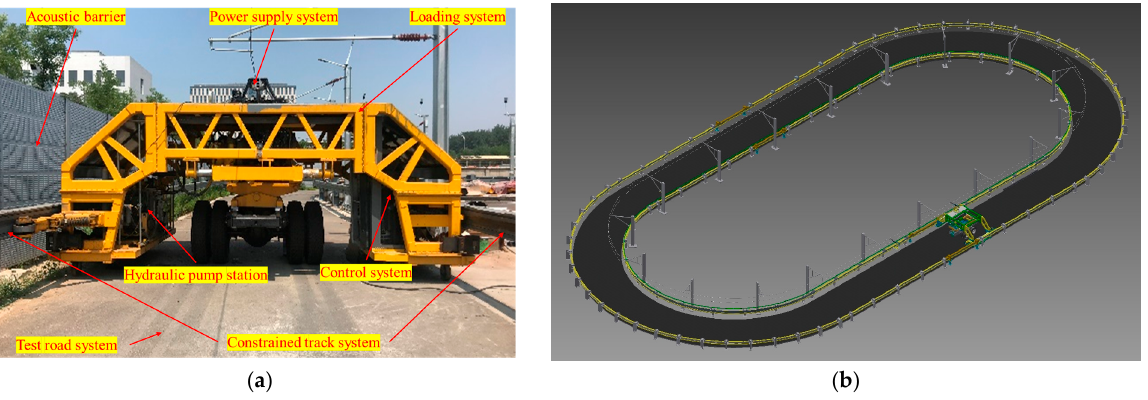
Figure 1. Natural Environment-Automatically Loaded Track. ( a ) Partial view of NE-ALT. ( b ) As- sembly drawing of